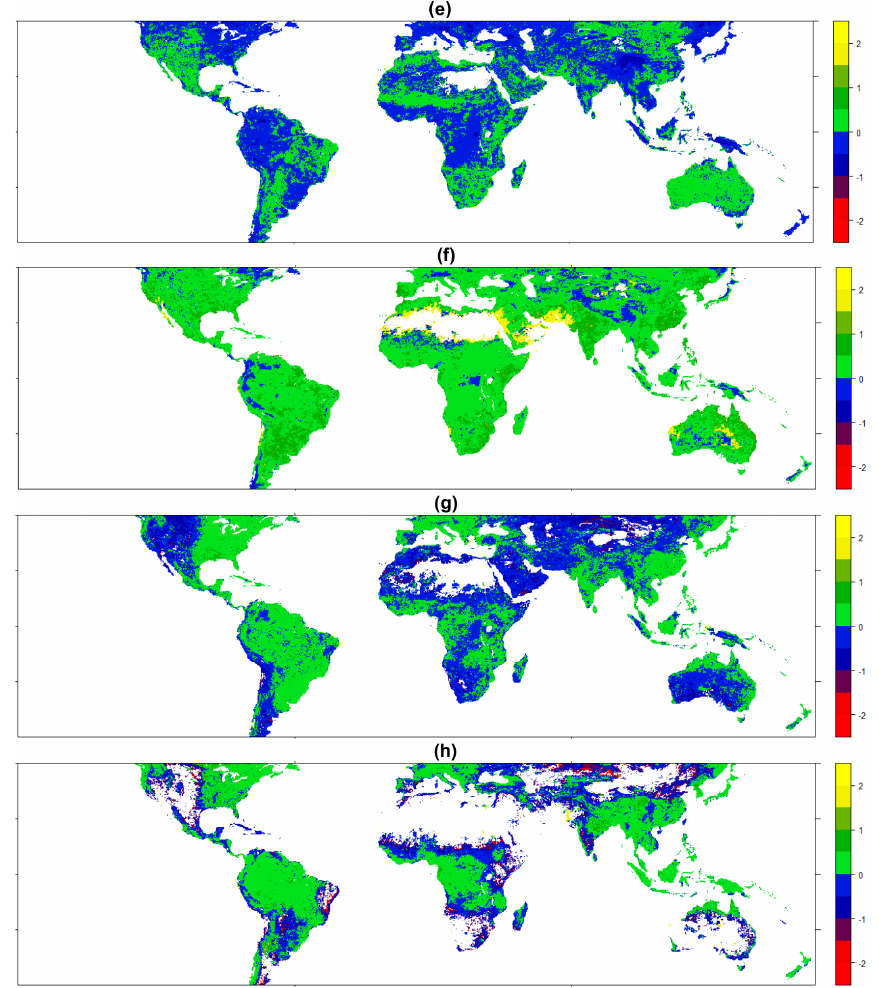
Figure 5. Values of log 10 (α X,j ) , where α X,j is the scaled data uncertainty in variable X (Eq. 1) (log 10 (α X,j ) < 0 indicates uncertainty in the predicted variable X attributable to the data is less than the variability in the input precipitation forcing data; > 0 indicates uncertainty in the predicted variable X is greater), where X is evapotranspiration (a, c, e, f) or runoff (b, d, g, h) and j refers to either high extremes (a, b, e, g) or low extremes (c, d, f, h) . Points on the scatter plots are coloured according to latitudinal zones (Fig. 1). Because of the density of overlapping points, only the envelope of points for each latitudinal zone is shown and the points with the highest uncertainty (uncertainty DIU ≥ ( 2 / 3 ) · (global maximum of DIU)). Linear regression lines for each latitudinal zone indicate the trend as precipitation increases within each zone (all regressions were significant at the 1% level), although, n.b., we do not contend in any way that the distribution of points shown is linear: these lines simply indicate a trend that is not clear to the eye from the envelopes displayed (which do not show the complete point cloud). Maps (e–h) show the corresponding spatial distributions of log 10 (α X,j ) values for each variable, with the colour scales corresponding to the vertical axis on scatter plot (a)